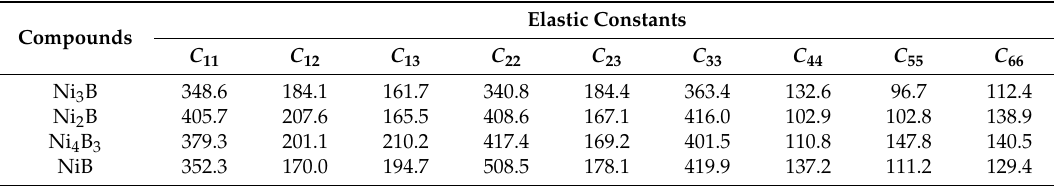
Table 2. The calculated elastic constants (in GPa) of Ni x B y